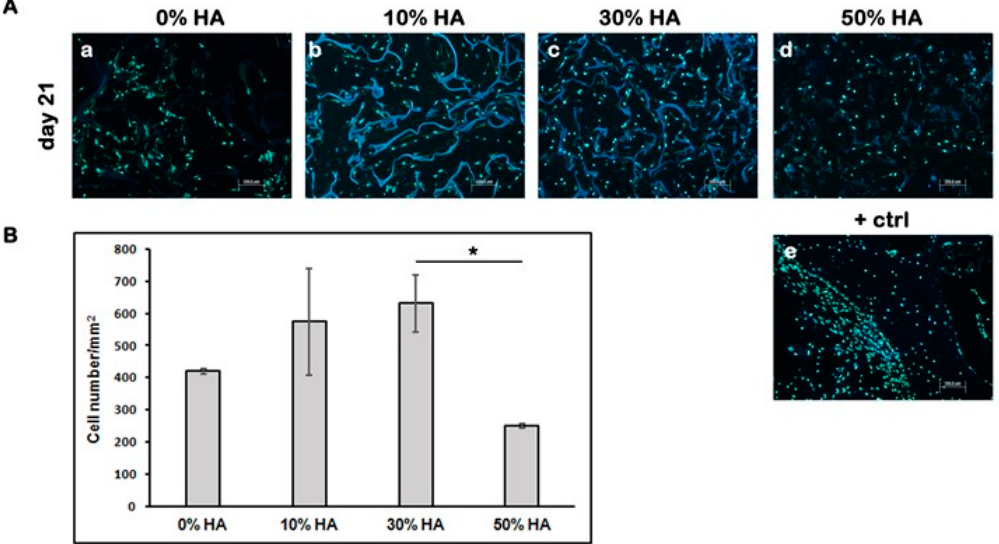
Figure 2. Cell distribution through the cross section of different Cht-HA scaffolds after 21 days of dynamic culture. ( A ) Fluorescence microscopic images of Hoechst stained cells on scaffolds composed of 0% HA ( a ), 10% HA ( b ), 30% HA ( c ) and 50% HA ( d ), respectively. Human bone sample was used as positive control (+ctrl). Representative images are shown at 100 × magnification ( n = 3). Scale bar represents 100 µ m. ( e ). ( B ) The cell number/mm 2 within each Cht-HA scaffold. Significant difference between two groups ( p < 0.05) is designated as (*).